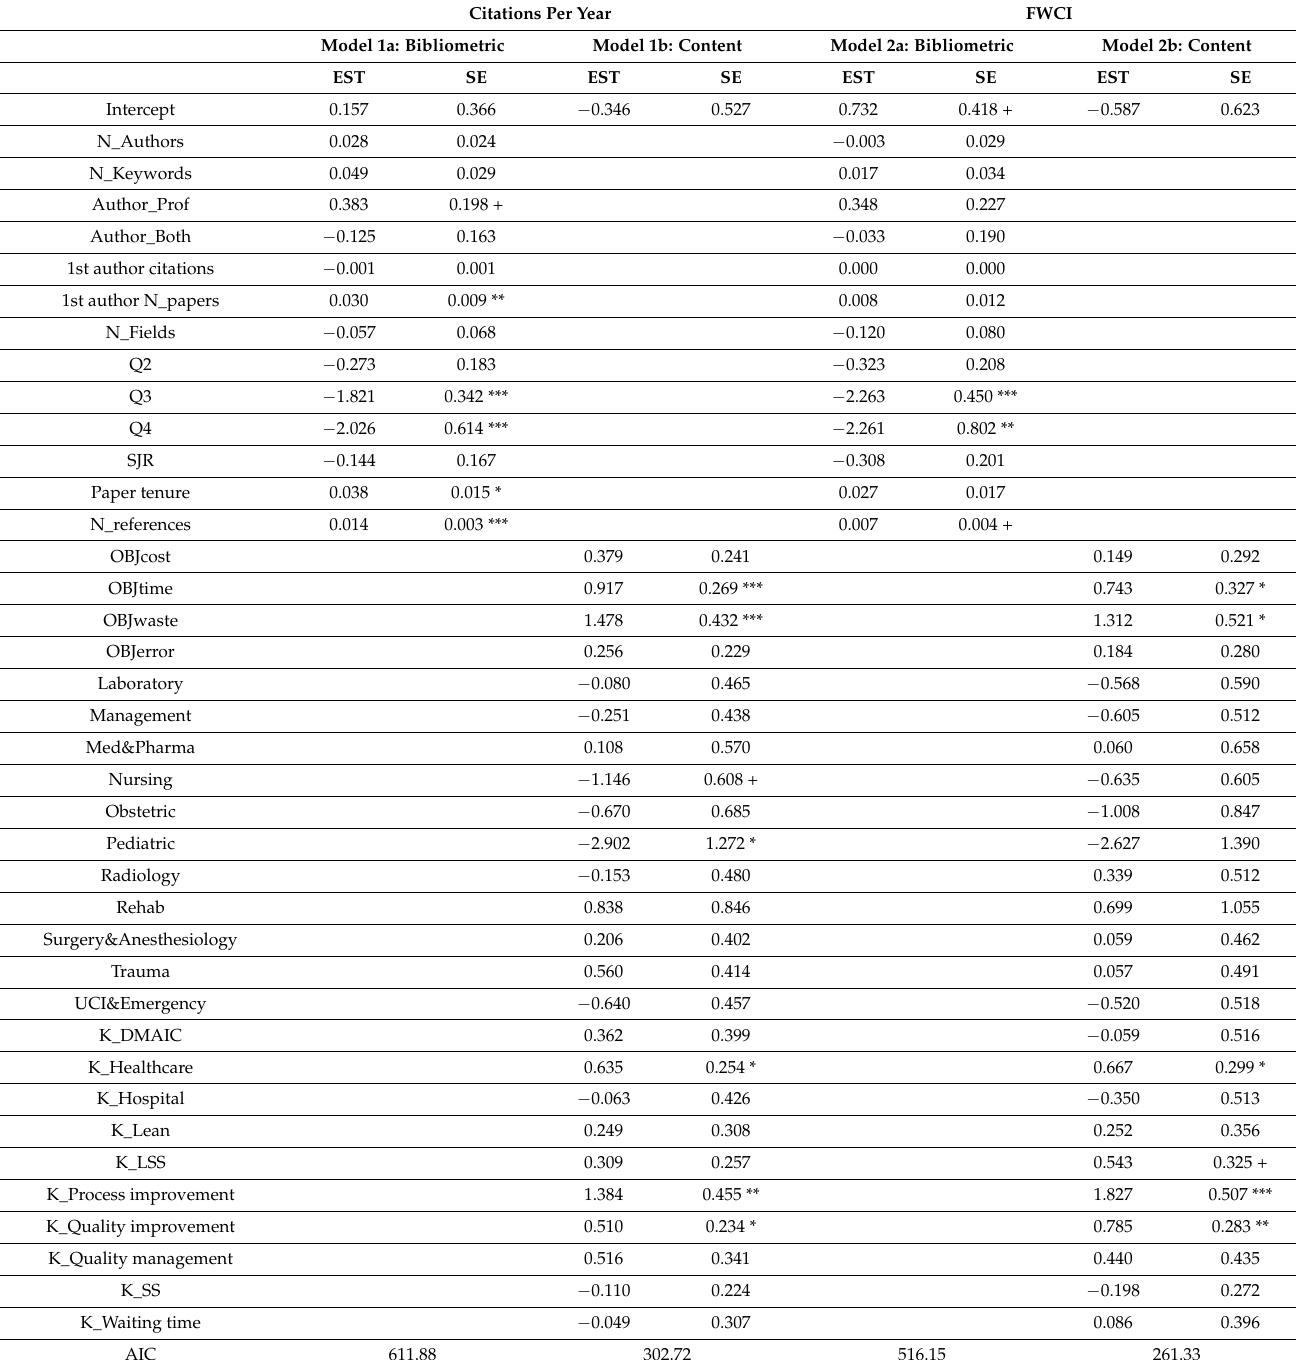
Table 2 shows the estimation models for the traditional impact metrics (Models 1 refers to citations per year as the dependent variable, and Models 2 has FWCI as the dependent variable). Table 3 shows the estimation models for altmetrics (Model 3 refers to Mendeley readers and Model 4 to abstract views as dependent variables, respectively). Each of the four models was split in two, labeled as submodel a (including the bibliometric determinants) and b (the paper’s content variables). Table 2. Zero-inflated negative binomial regression model for traditional metrics of research